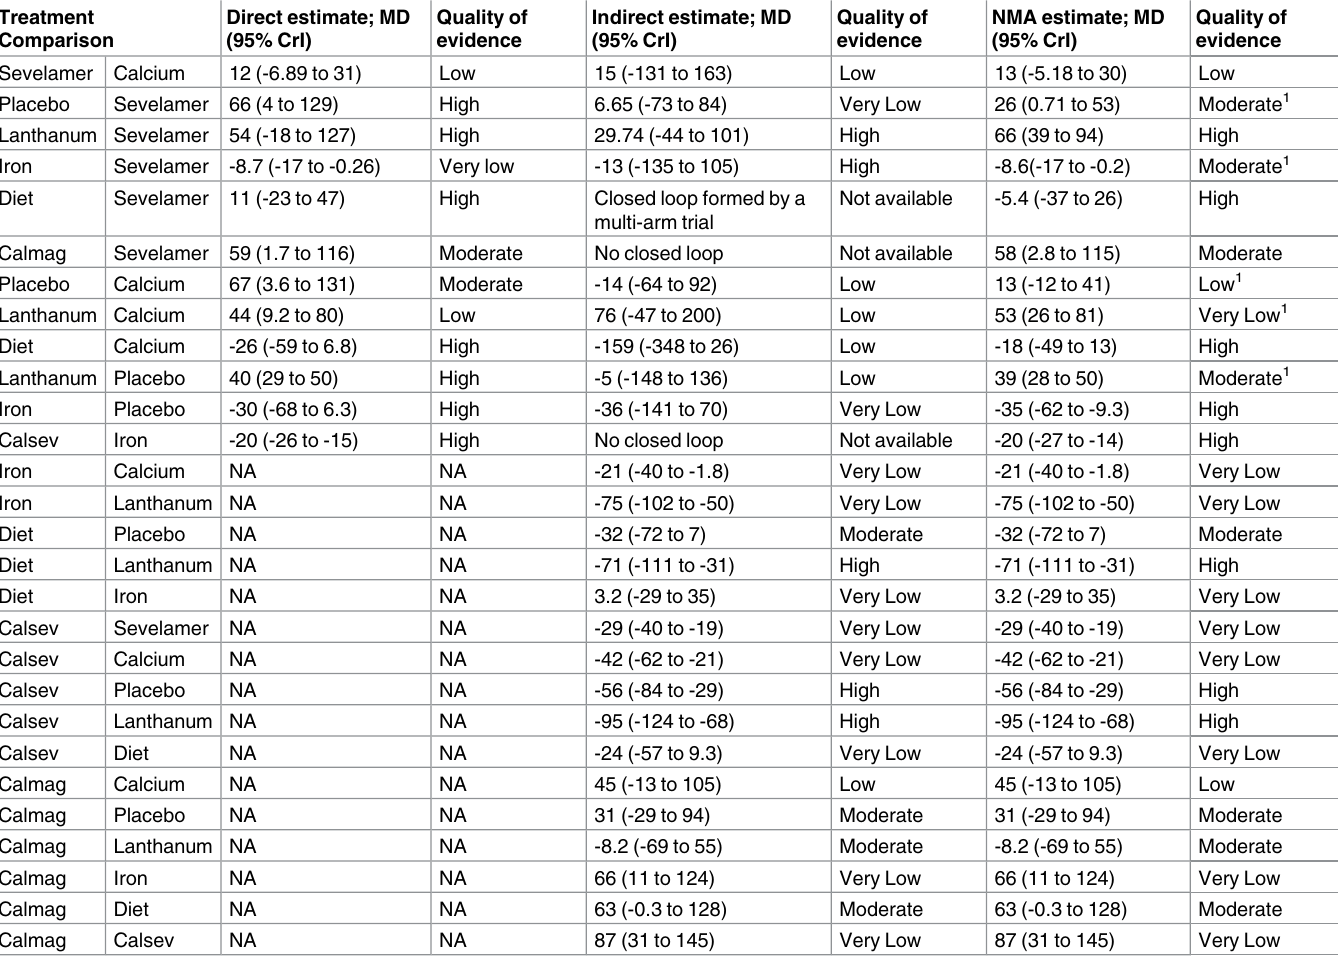
Table 3. Direct, indirect, and NMA estimatesof parathyroid hormone with 95% credible intervals and GRADE assessments from each pairwise comparison within the phosphate-binder network. Treatment